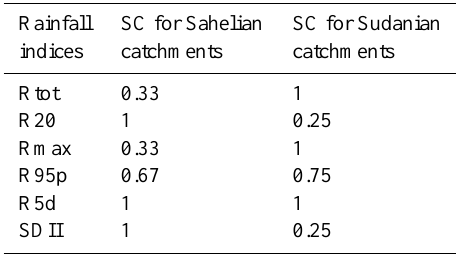
Table 7. SC and Cramer criterion values for precipitation index trends compared to Qmax trends and nPOT trends for the seven homogeneous catchments of Burkina Faso.